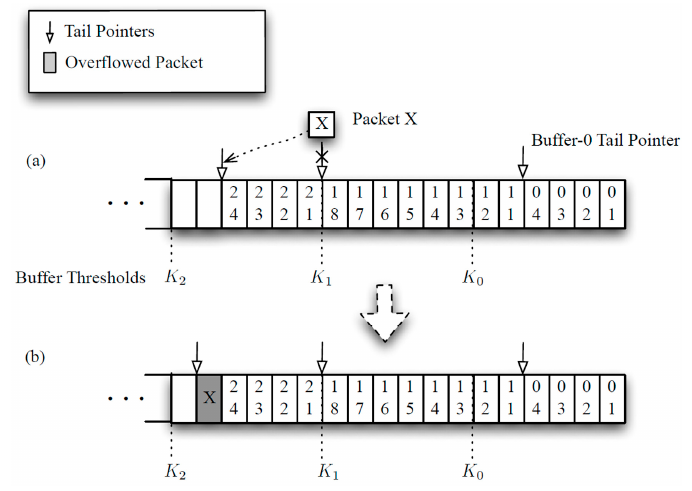
Figure 4. First scenario of a packet overflow. K 0 = 6, K 1 = 12, K 2 = 18.